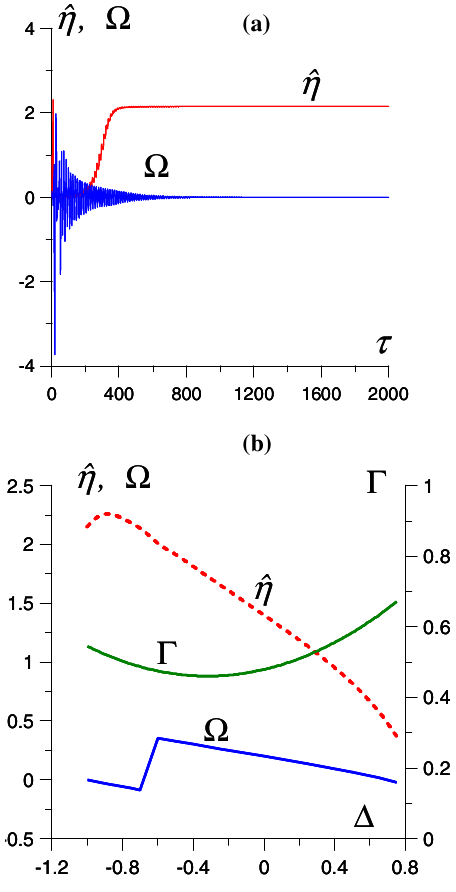
FIG. 8. Modeling of FEL with advanced upstream and 2D downstream Bragg reflectors. Establishment of the steady-state oscillation regime: temporal dependence of normalized effi- ciency ^ (cid:13) and frequency shift (cid:3) at (cid:2) ¼ (cid:2) 0 : 5 (a); normalized efficiency ^ (cid:13) , the electron frequency shift (cid:3) , and the factor (cid:4) vs electron synchronism detuning parameter (cid:2) in the steady-state regime ( L 1 ¼ 1 , L 0 ¼ 5 : 5 , L 2 ¼ 0 : 8 , (cid:4) 1D ¼ 0 : 7 , (cid:4) 2D ¼ 0 : 5 , (cid:7) ¼ 0 : 2 , C (cid:1) 1 : 4 (cid:10) 10 (cid:2) 4 ) (b).